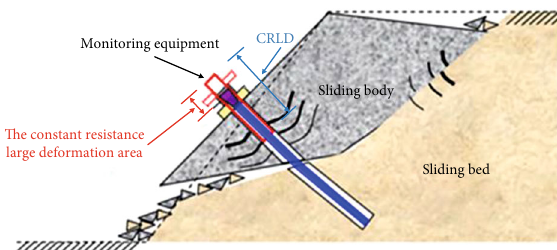
Figure 10: Schematic diagram of landslide measurable mechanical